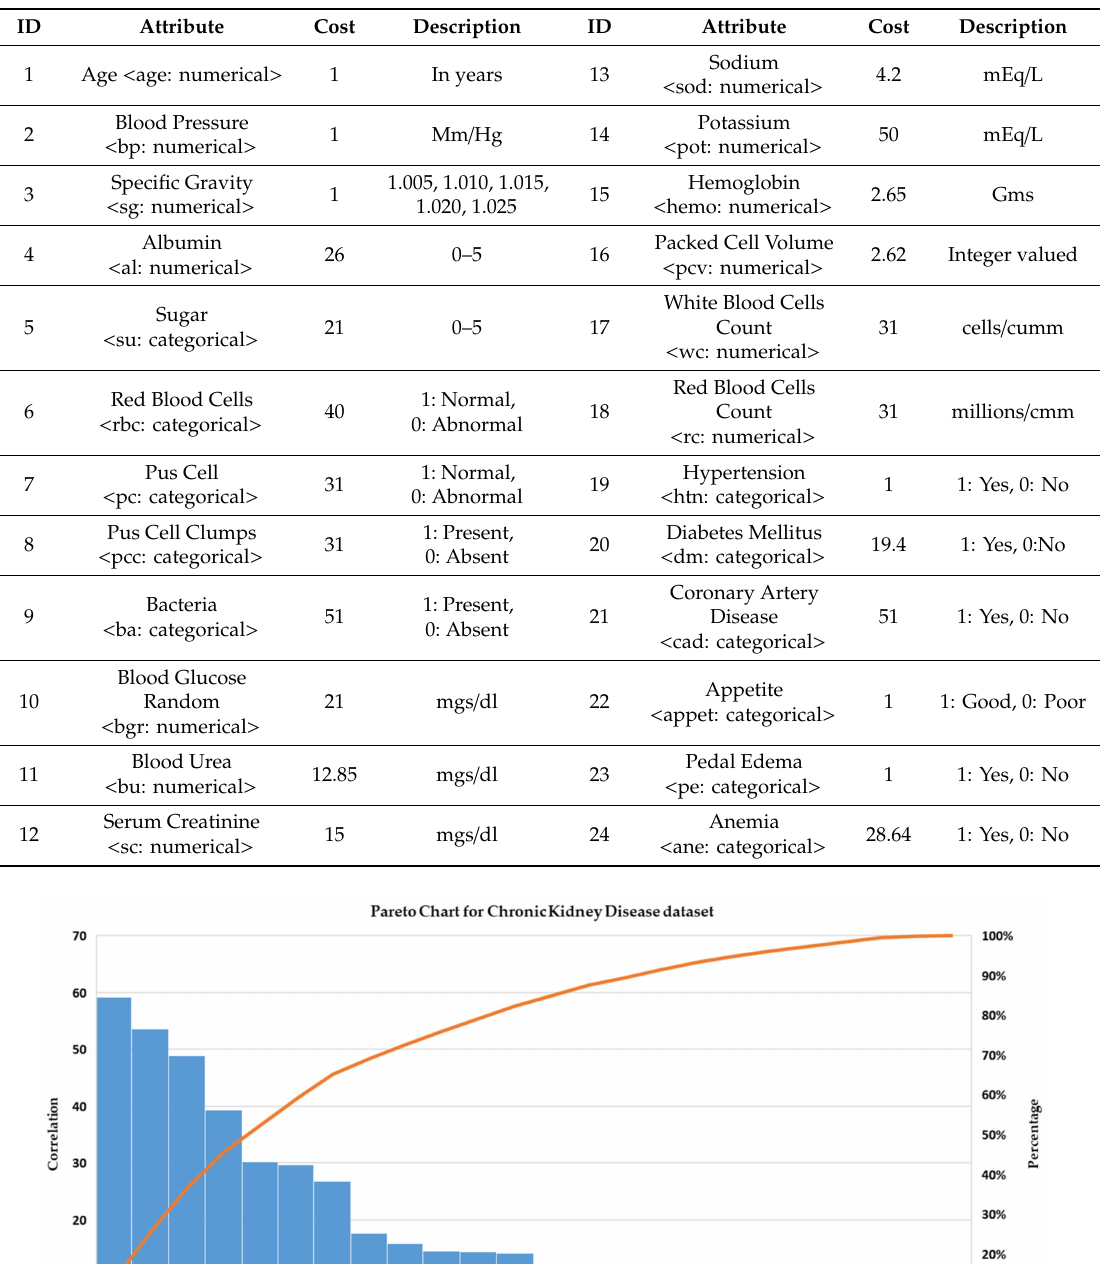
Table 4. Chronic Kidney Disease (CKD) dataset description.